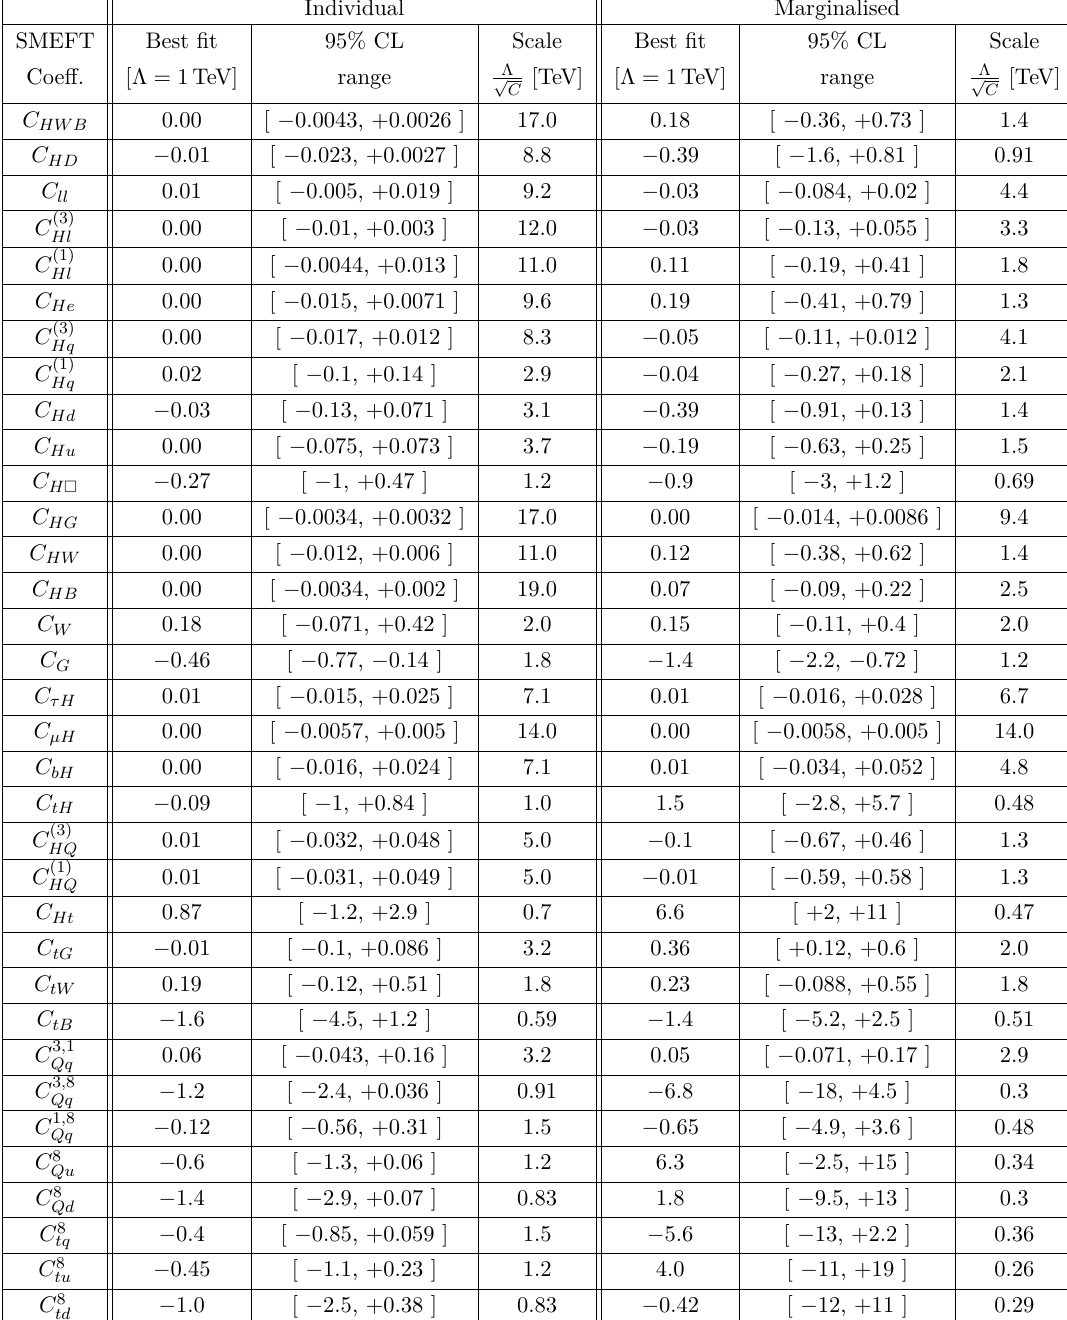
Table 6 . Table of numerical results in figure 6 from the global fit to the electroweak, diboson, Higgs and top data in the top-specific SU(2) 2 × SU(3) 3